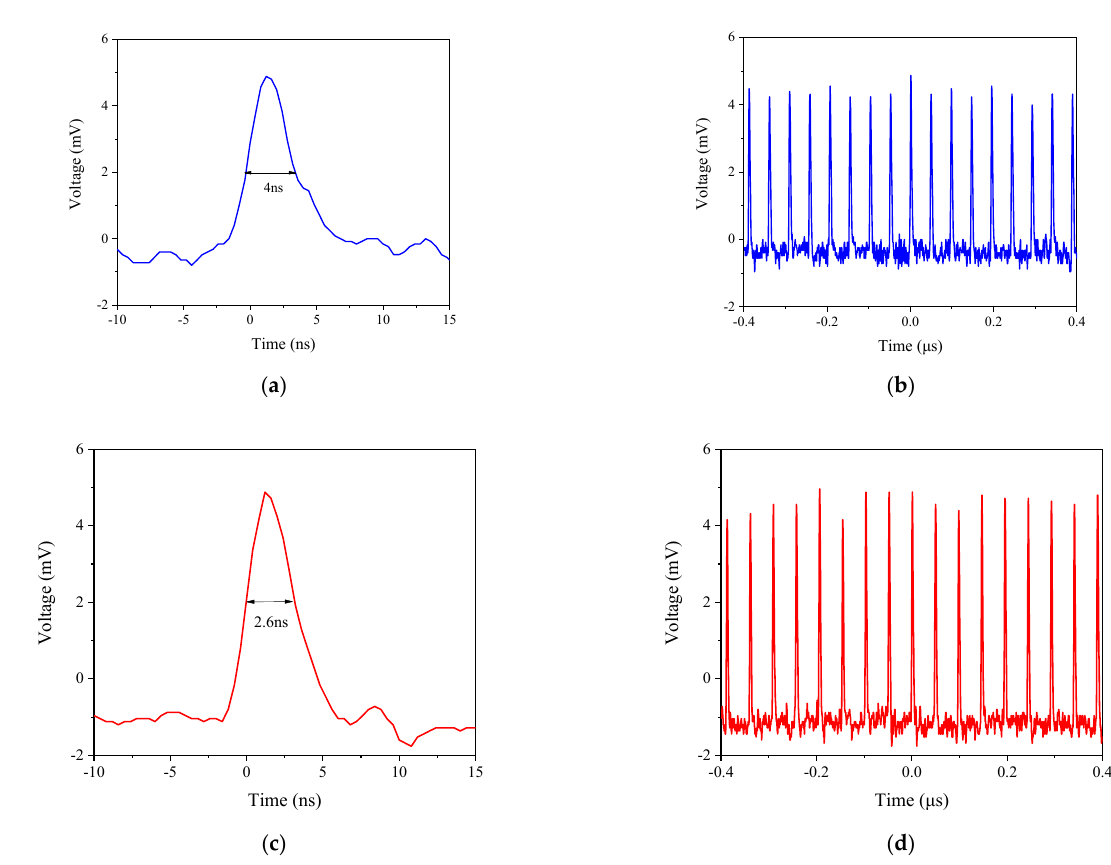
Figure 9. The temporal characteristic of the FGRL when the pump source is at the maximum power and the repetition is 20 MHz. ( a , b ) The shapes and the series of the pump pulses. ( c , d ) The shapes and the series of the Stokes pulses.